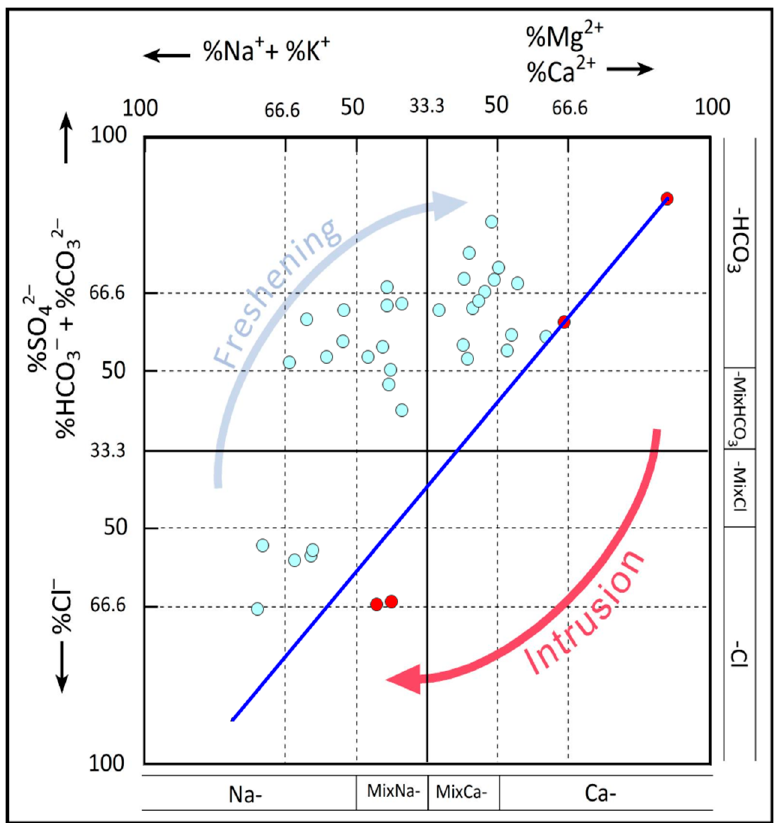
Figure 12. Hydrochemical facies evolution model for the Sfax coastal shallow aquifer (Blue: freshwater, red: water affected by SWI). Table 3. Phases and facies of groundwater samples in the Sfax coastal shallow aquifer.